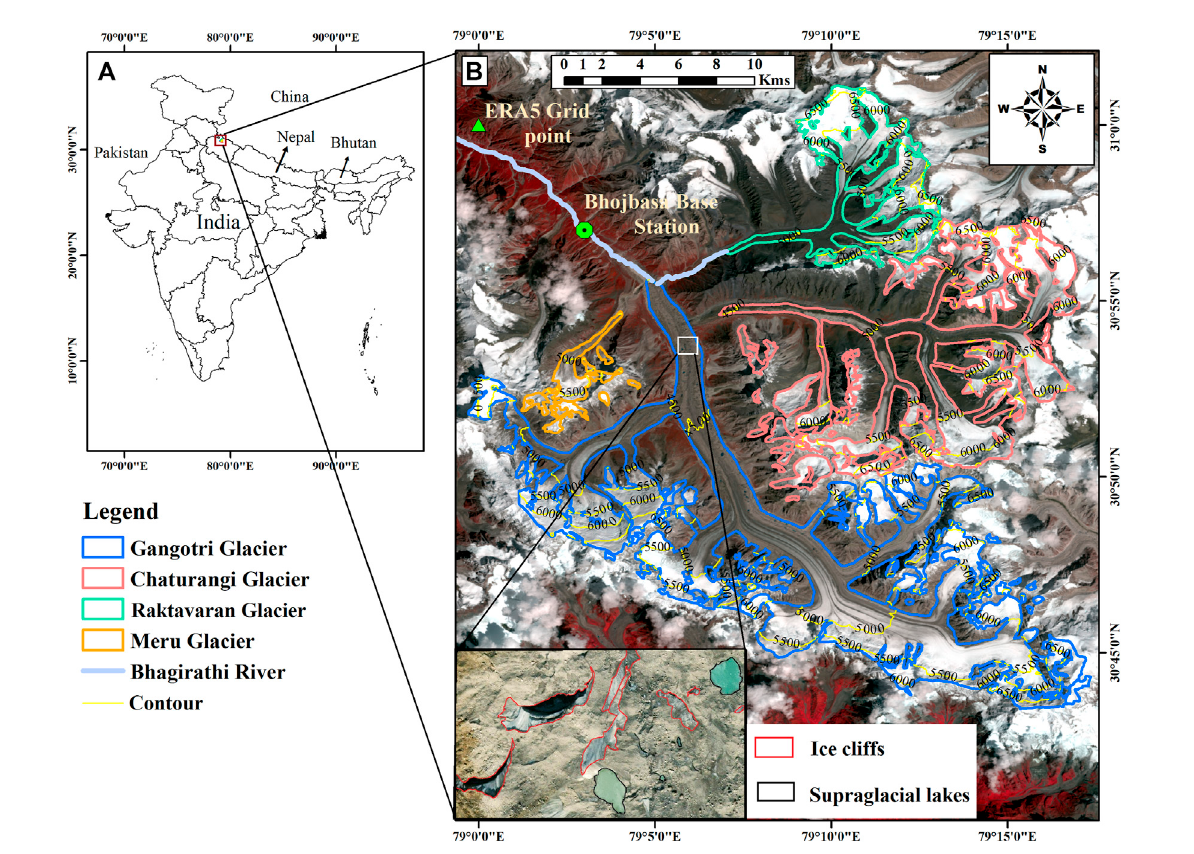
FIGURE 1 (A) Panelshows thelocationoftheGangotriGlacierSystem,India. (B) Panelshowsall fourglaciers Gangotri(blue),Chaturangi(red),Raktavaran (green) and Meru (yellow) on Landsat eight image of 13th September 2017, and the inset (left bottom of B) shows the enlarged view of ice cliffs (red outlines) and supra-glacial lakes (black outlines) on the surface of Gangotri